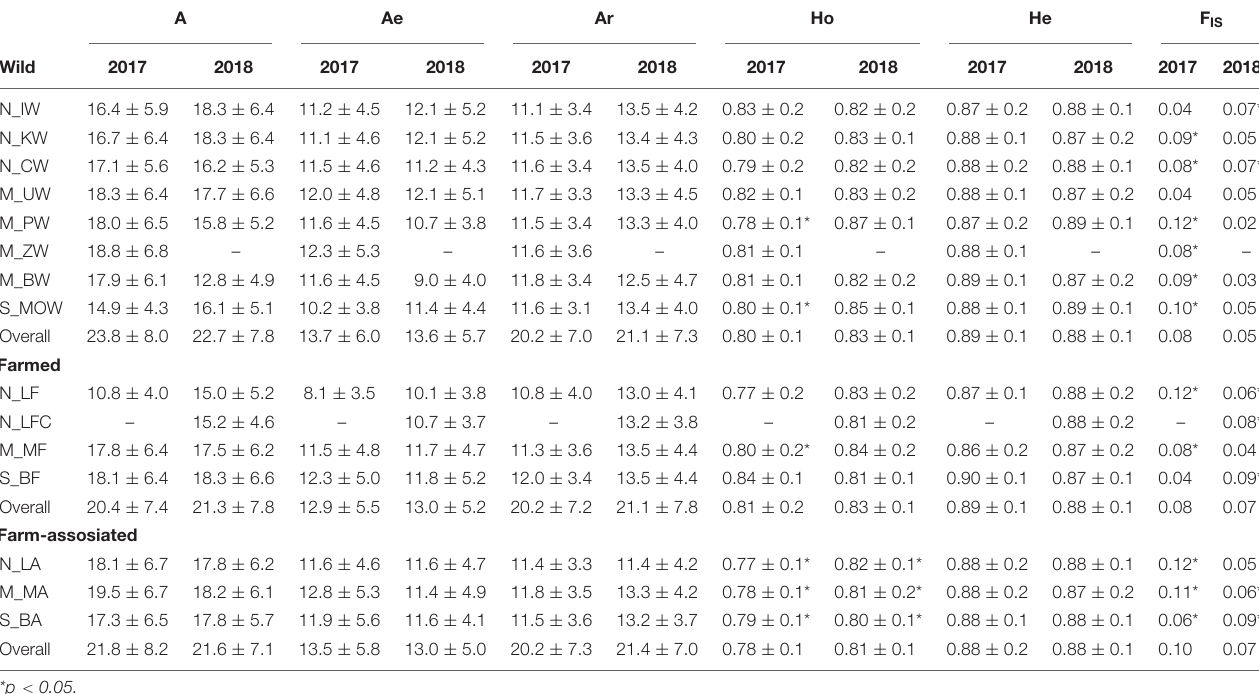
TABLE 2 | Summary statistics for genetic variation of Ostrea edulis in the Adriatic Sea showing the average number of alleles (A), effective number of alleles (Ae), allelic richness (Ar), expected (He) and observed (Ho) heterozygosity, and fixation index ( F IS ). A Ae Ar Ho He F IS